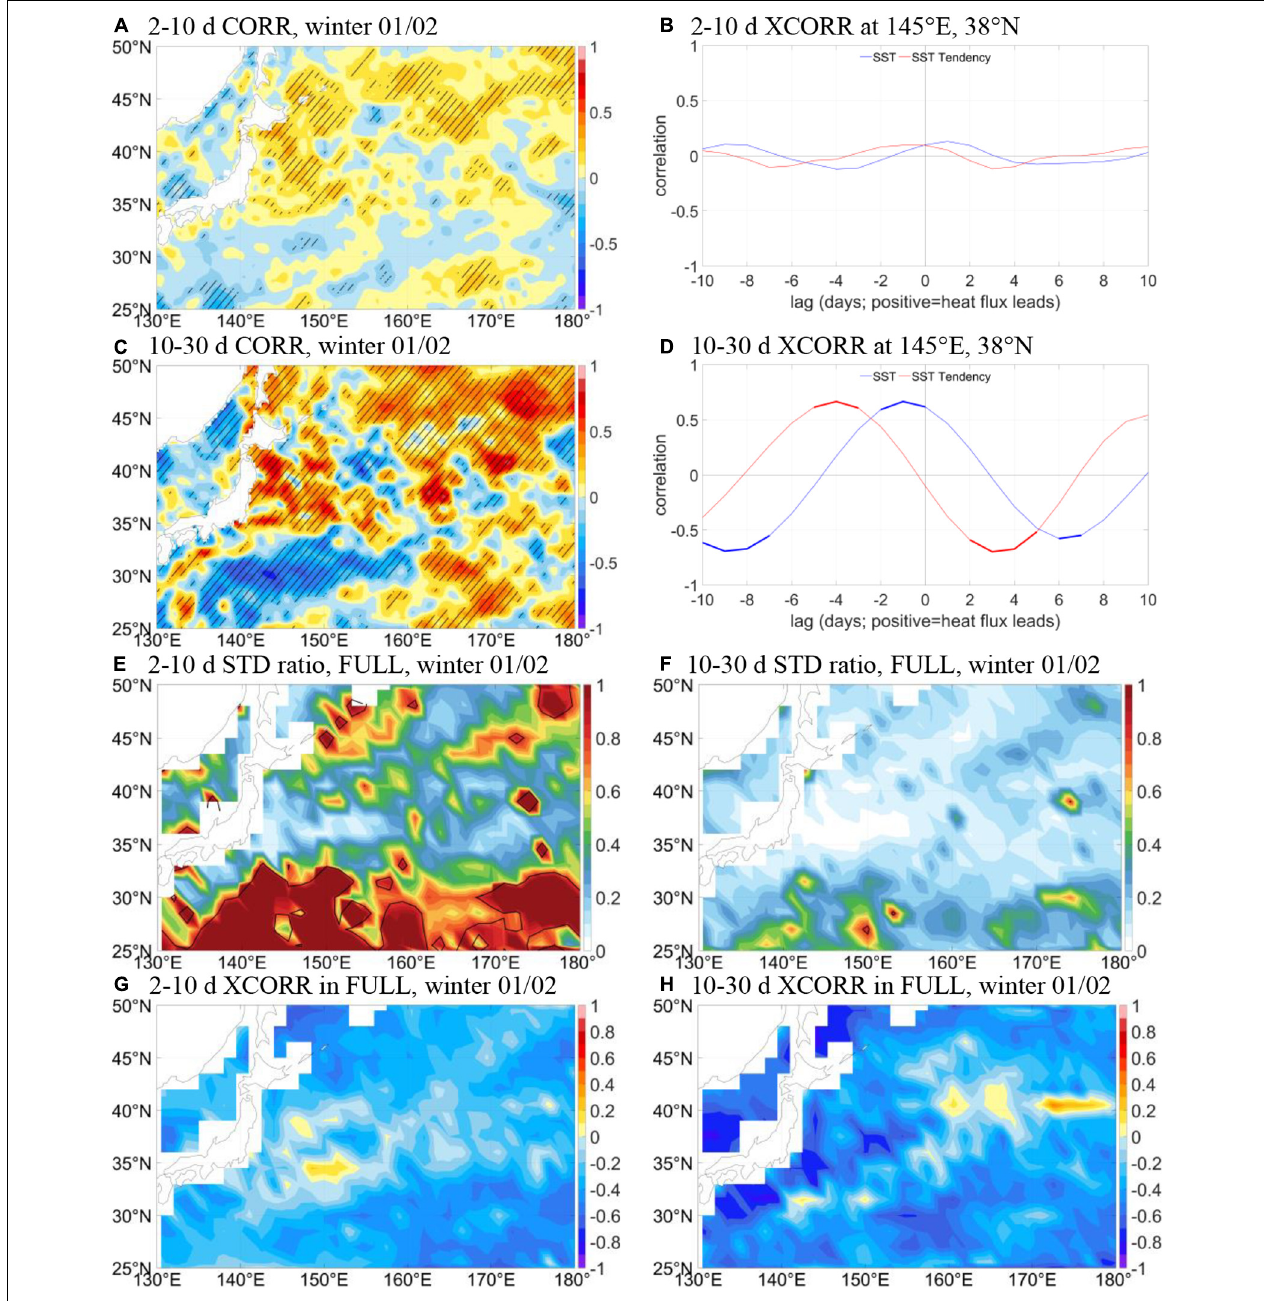
FIGURE 8 | (A–D) Same as Figure 4 but for winter 2001/02. (E,F) Same as Figure 5 but for winter 2001/02. (G,H) Same as Figures 7E,F but for winter 2001/02.